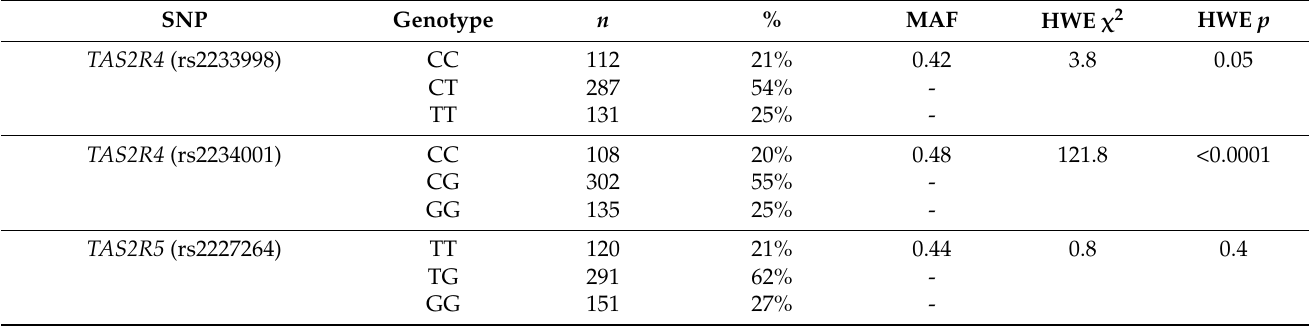
Table 3. TAS2R genotype